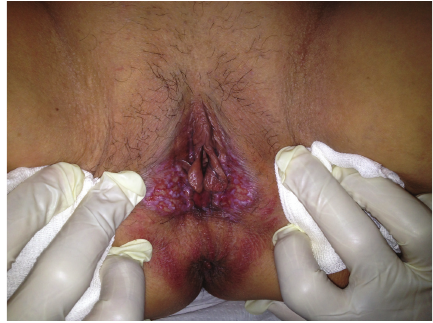
Figure 3: Langerhans cells staining positive for S-100 on immuno- histochemical staining × 200.